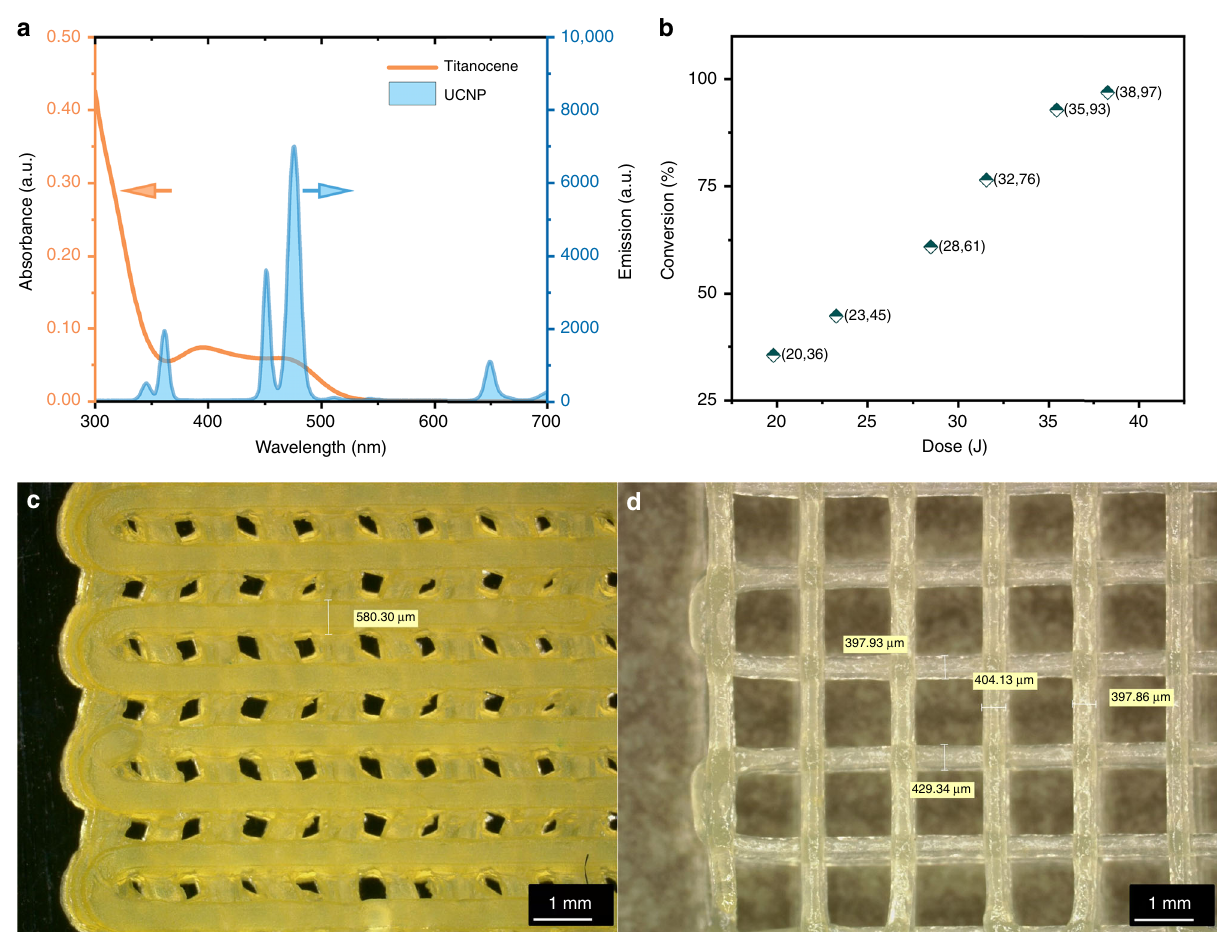
Fig. 2 Matching of initiation system and differences between varied photopolymerization conditions. a Absorption spectrum of titanocene and emission spectrum of UCNP; b the conversion of vinyl group vs. the irradiationdose as monitored by ATR-FTIR; optical images of the structures by c post-NIR irradiated or d in-situ NIR curing, the scale bar is equivalent to 1